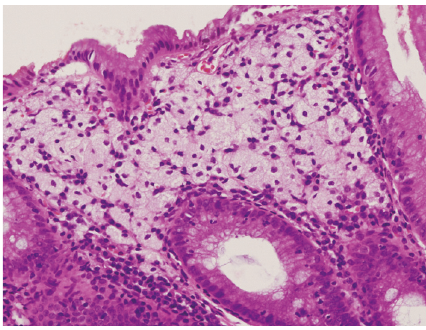
Figure 3: Pathological image of case 2. Biopsy examination reveals massive deposition of xanthoma cells within the rectal